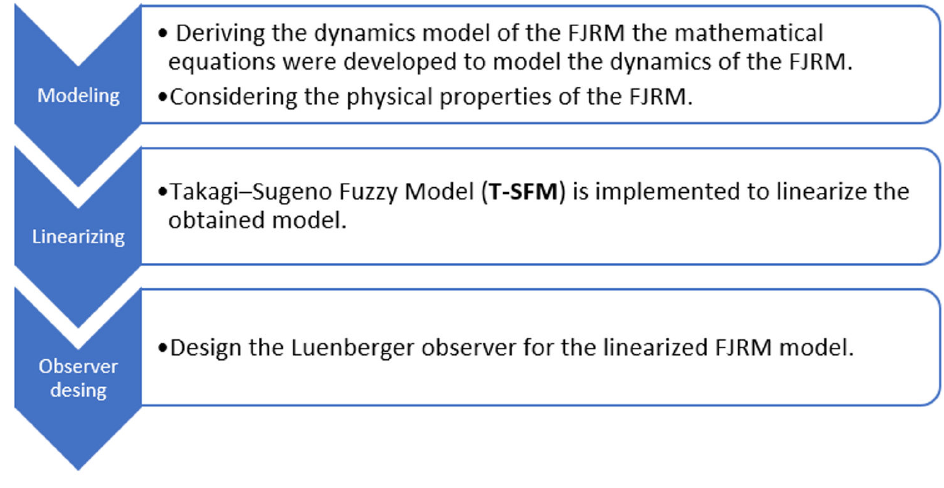
Figure 1. An overview of the proposed